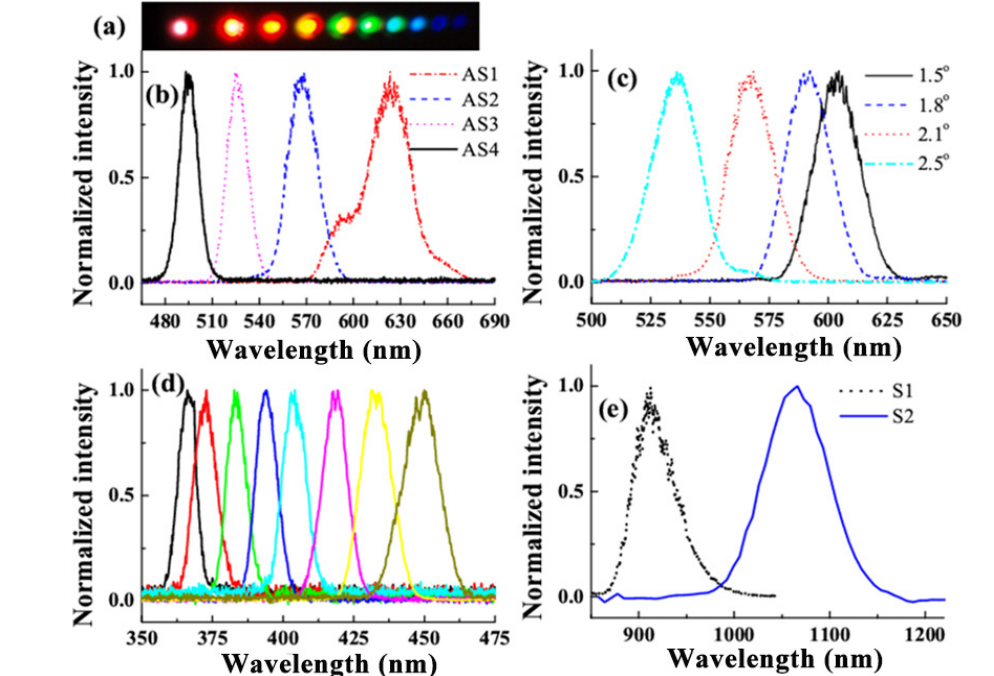
Figure 6. ( a ) Photograph of the first ten anti-Stokes sidebands on a white paper set 1 m far from the nonlinear medium; ( b ) The spectra of AS1-AS4 with cross-angle of 2.1° for two pump beams; ( c ) The spectra of AS2 with different cross-angles; Spectra of ( d ) AS8-AS15 and ( e ) two Stokes signals S1 and S2 with cross-angle of two pump beams set as 1.5°